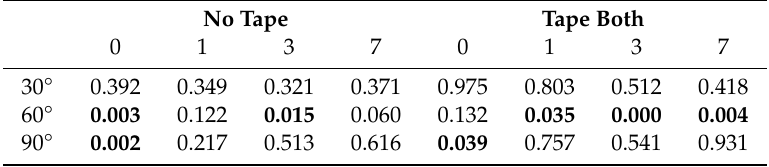
Table A3. p -values for the data presented in Figure 9 (untaped and taped channels with lengthwise grooves), generated using a two-tailed, unequal variance t -test comparing the 30 ◦ , 60 ◦ , and 90 ◦ conditions to the 0 ◦ (vertical wicking). Values below 0.05 are in bold